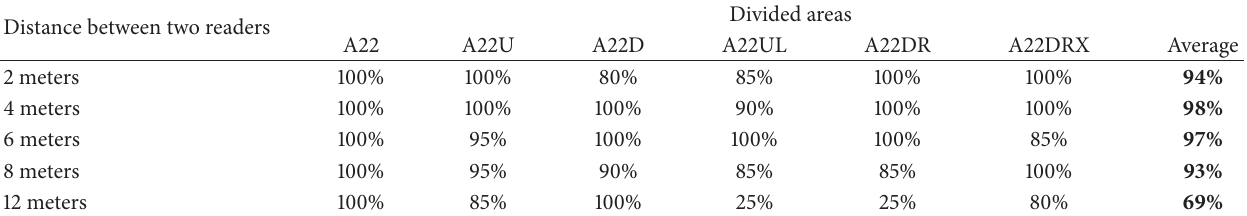
Table 5: The degree of accuracy of detecting the location of tags in divided areas under different distances between two readers. Divided areas Distance between two readers A22 A22U